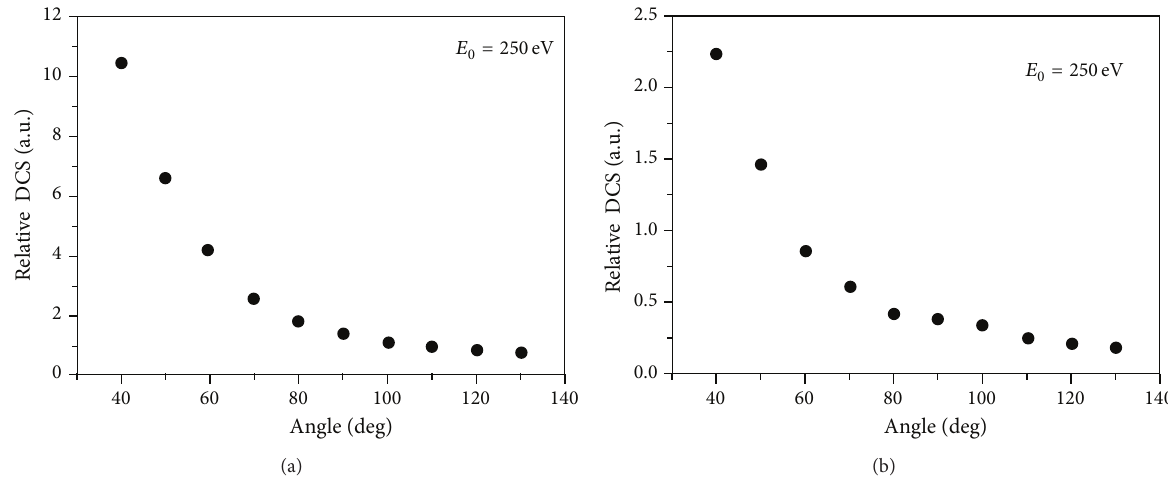
Figure 12: (a) Elastic and (b) inelastic DCS of Helium at 250 eV impact energy.